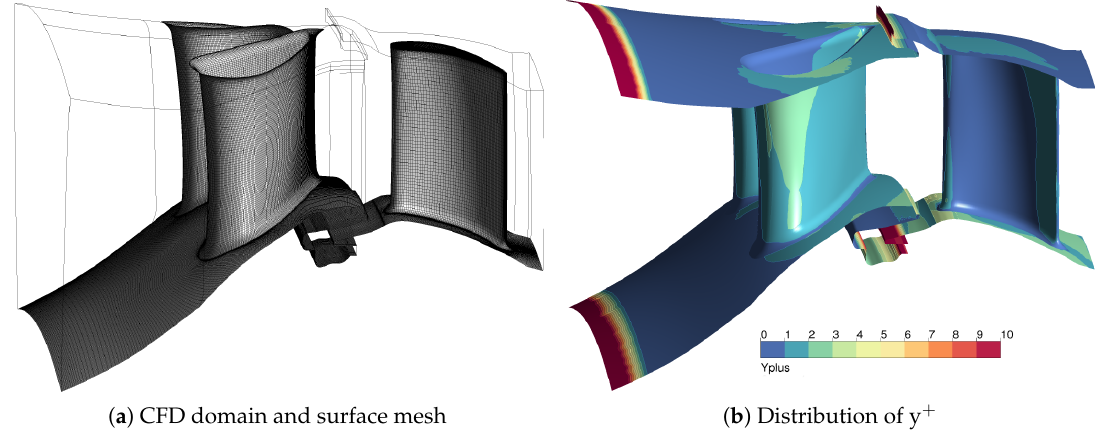
Figure 9. CFD domain and y + distribution.